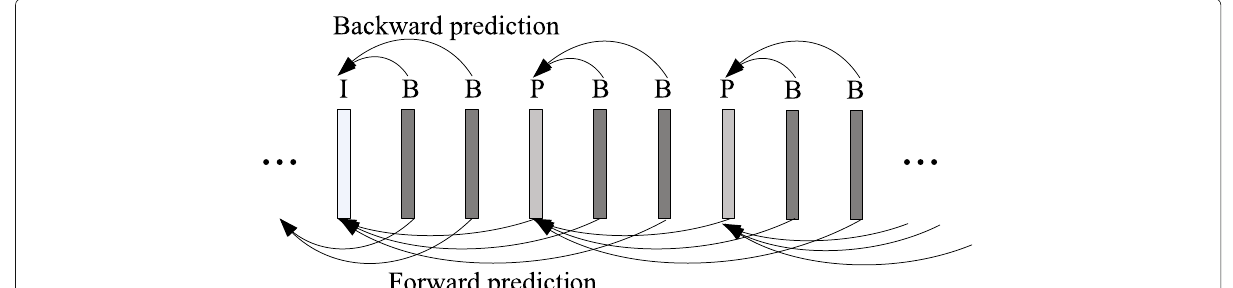
Fig. 2 The encoding reference relationship with λ = 2 and Number Reference Frames =